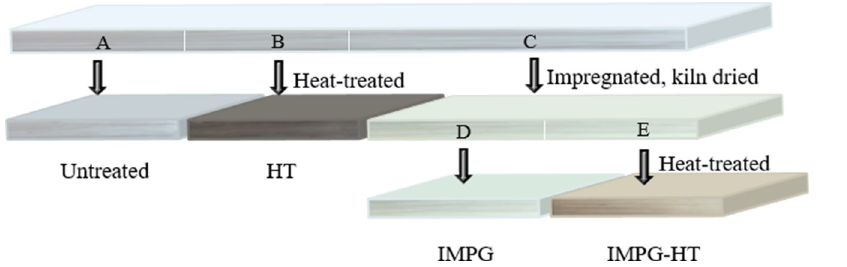
Fig 1. The processing diagram of poplar wood samples.